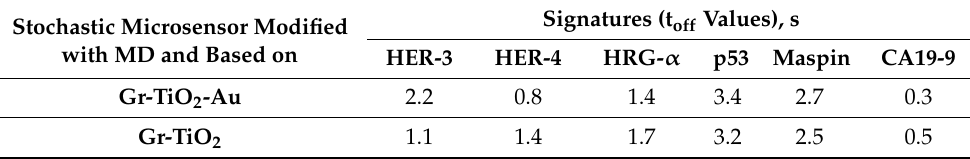
Table 2. Selectivity of the stochastic